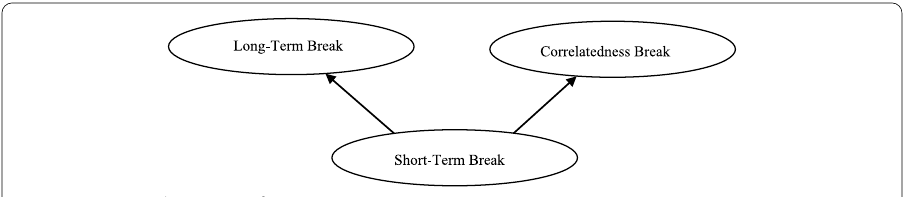
Fig. 1 Basic causal structure of testing